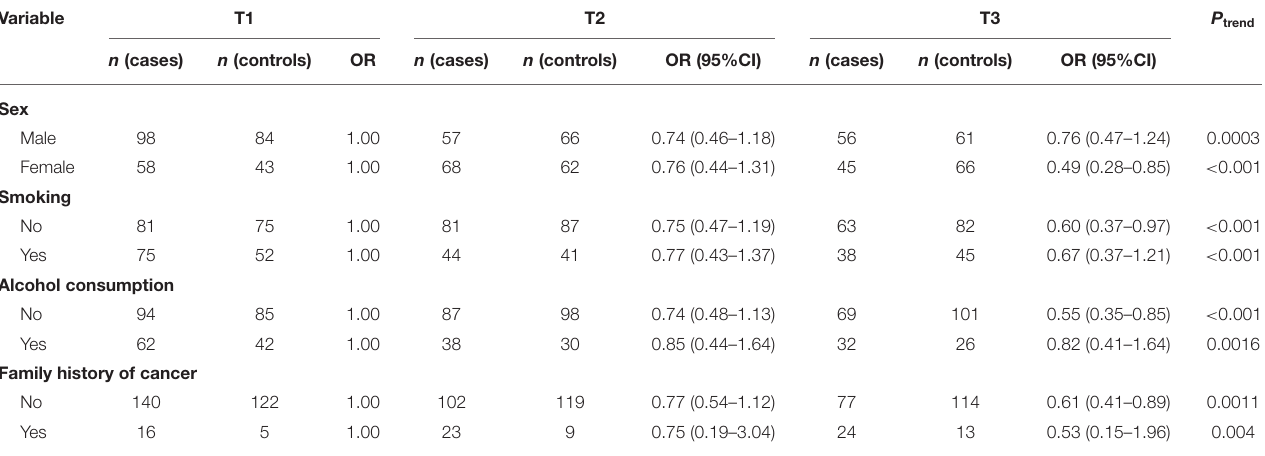
TABLE 5 | Stratification analysis of dietary vitamin C intake and oral